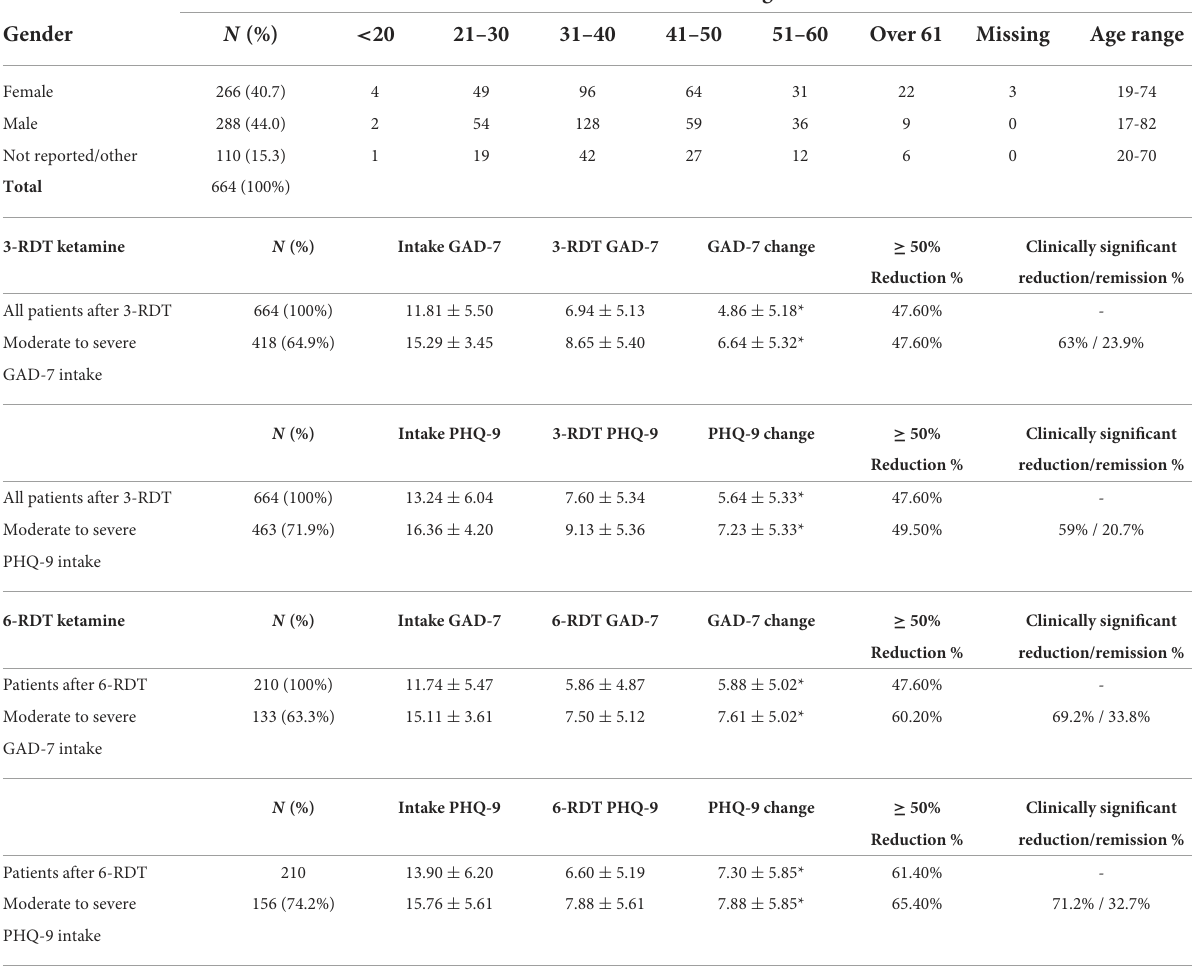
TABLE 2 Demographic characteristics and GAD-7 and PHQ-9